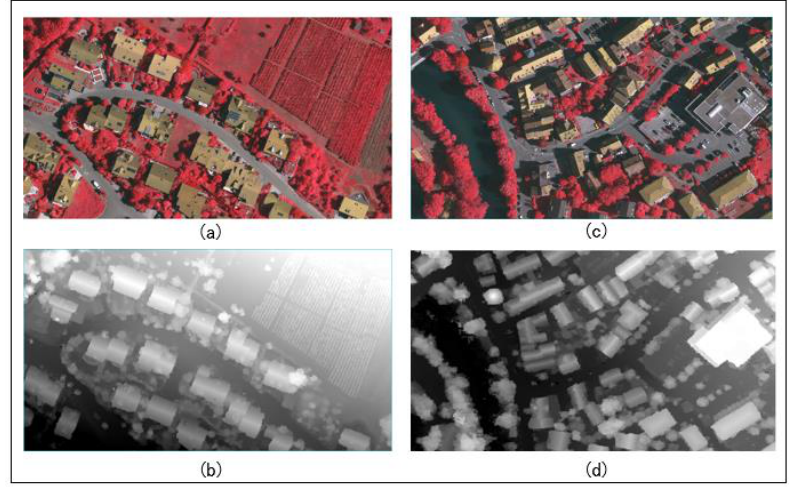
Figure 1. Datasets: (a) aerial image (Data 1), (b) DSM (Data 1), (c) aerial image (Data 2), (d) DSM (Data 2)